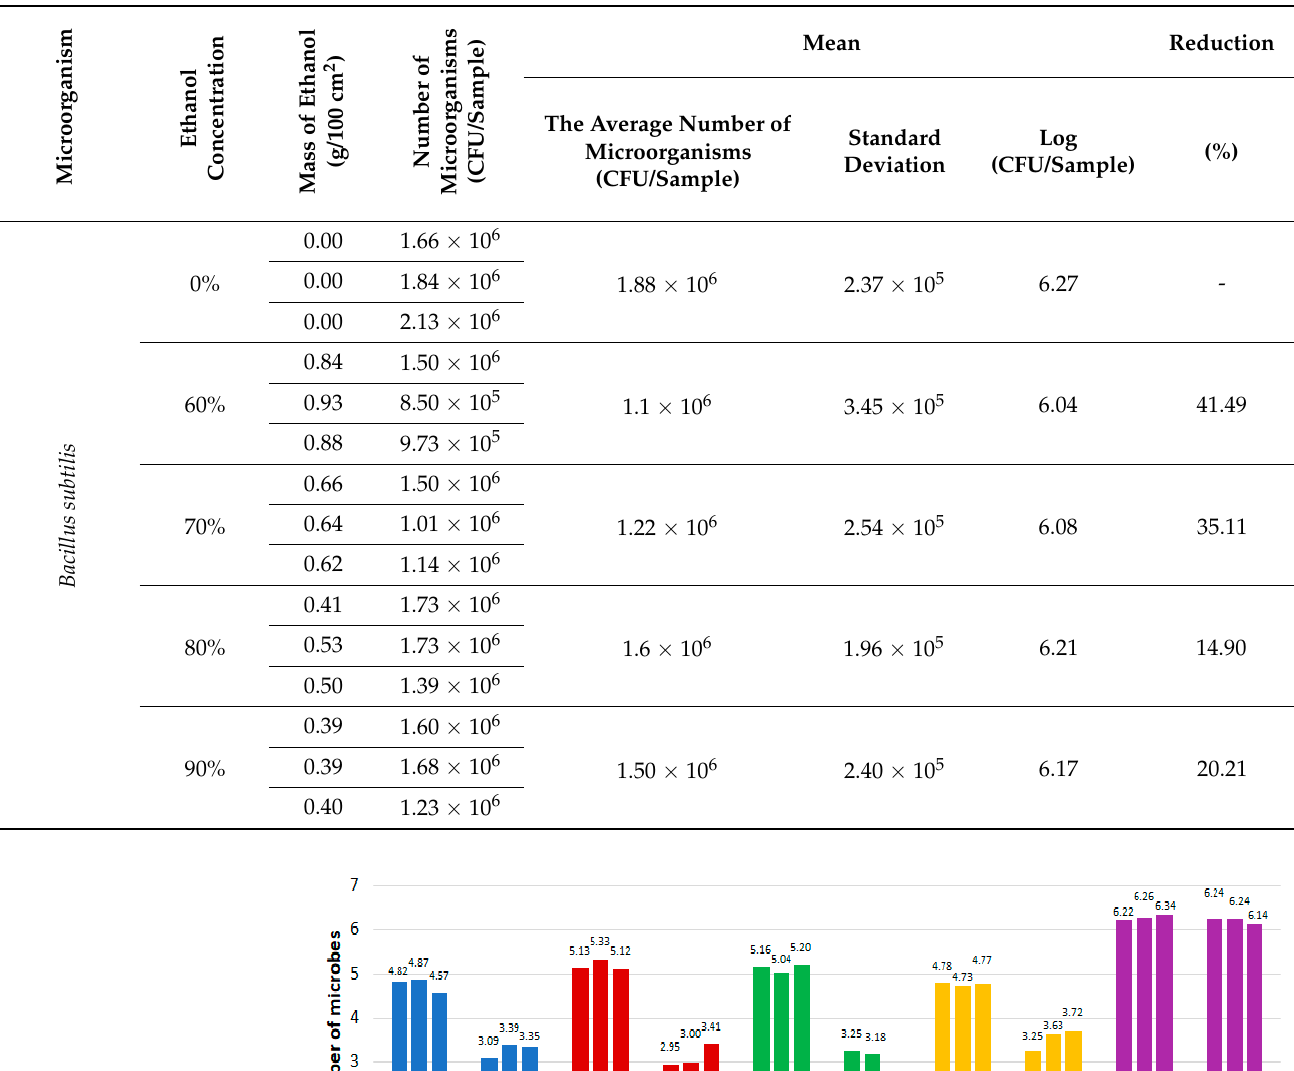
Table 2. Evaluation of the biocidal effectiveness of the short-term effect of ethanol in the form of mist against Bacillus subtilis on a model fabric.